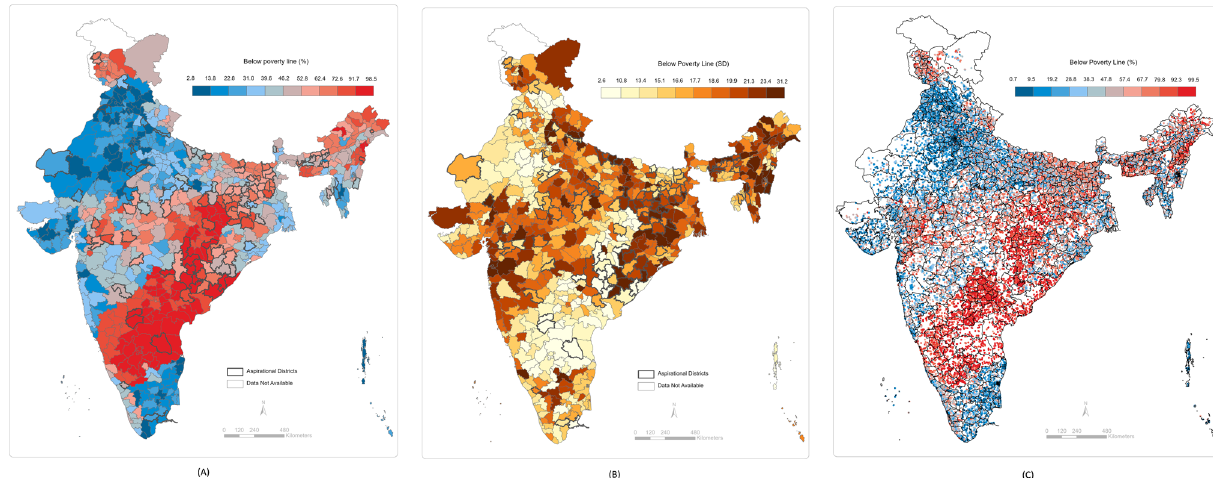
Fig. 7 Small area maps of BPL households throughout India. A Geographic prevalence of BPL individuals across 640 districts in India. B District-level distribution of cluster-level inequality for BPL individuals across 640 districts in India. C Geographic prevalence of BPL individuals across 30,170 clusters in India.